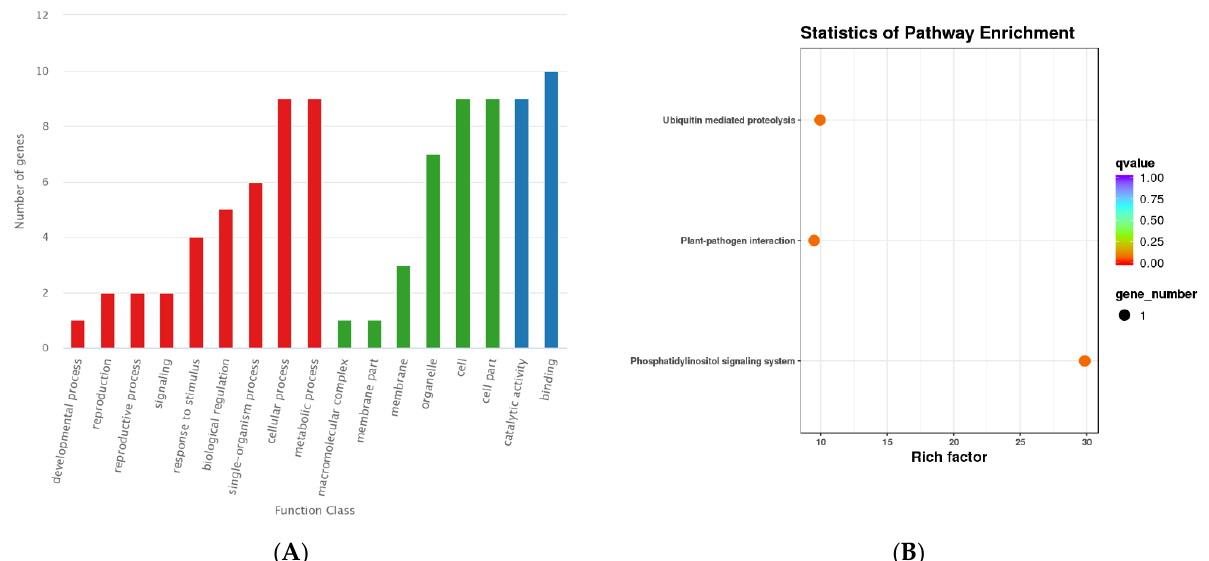
Figure 3. Gene ontology (GO) and Kyoto encyclopedia of genes and genomes (KEGG) enrichment analysis for host genes of DEcircRNAs. ( A ) The most enriched GO terms of the host genes of DEcircRNAs. ( B ) The most enriched KEGG pathways of the host genes of DEcircRNAs.